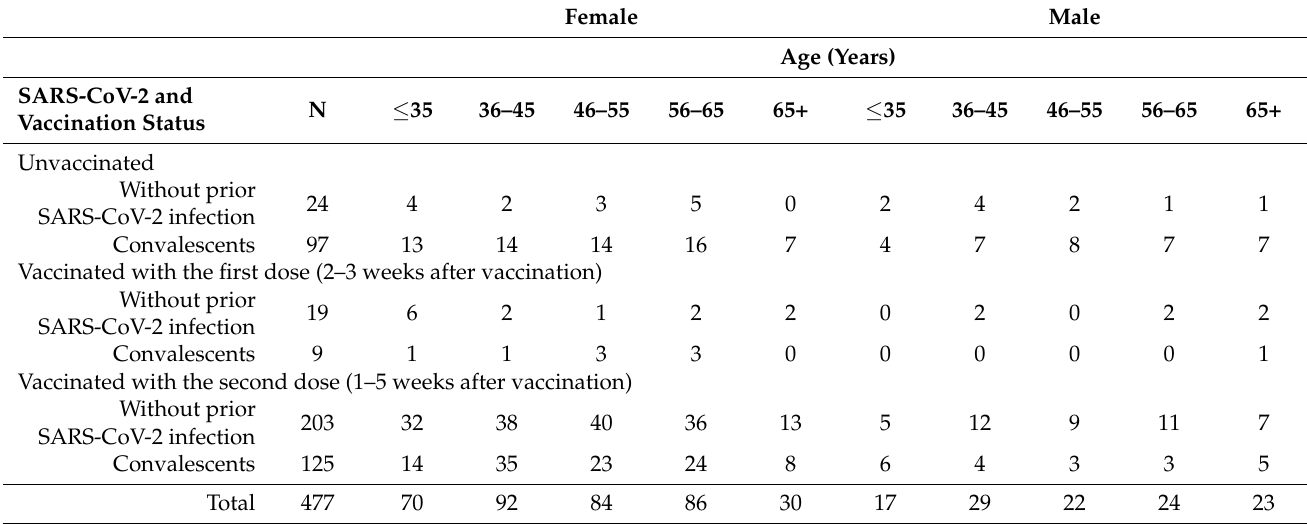
Table 1. Characteristics of the frequency of the studied subgroups, taking into account the sex and age of the patients. Female Male Age